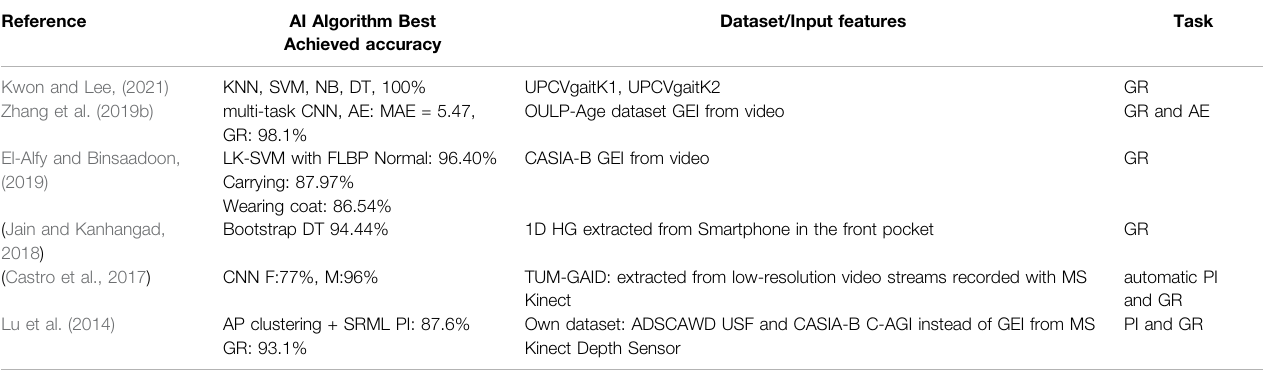
TABLE 11 | Gender recognition (GR).